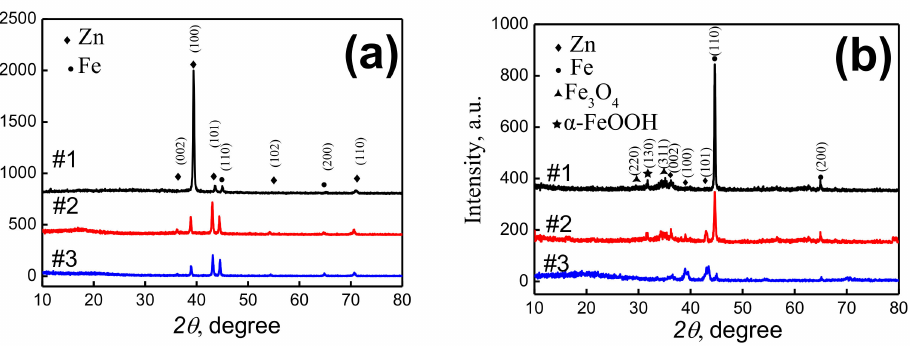
Figure 6. X-ray diffraction patterns of specimens #1~#3: ( a ) for specimens before corrosion; ( b ) for specimens after 72 h